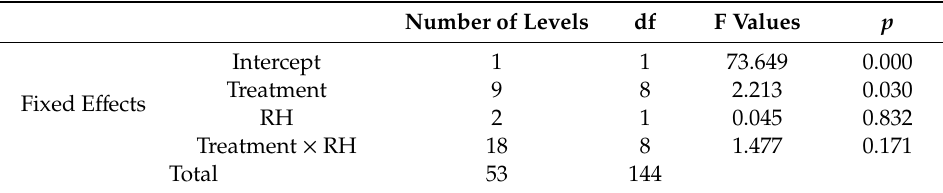
Table 4. Mixed Model Analysis of latent infection incidence along time for the di ff erent treatments and under two RH conditions. Number of Levels df F Values p